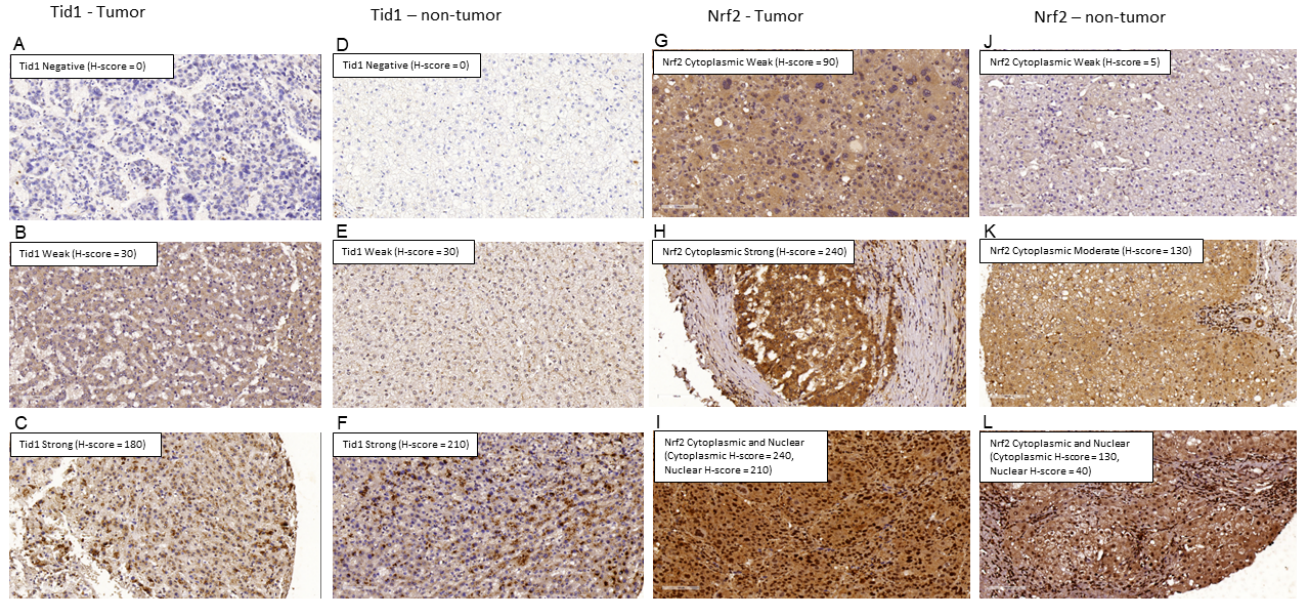
Figure 5. Examples of Tid1 expression in the tumor and non-tumor part. ( A ) Negative Tid1 expression in the tumor part. ( B ) Weak Tid1 expression in the tumor part. ( C ) Strong Tid 1 expression in the tumor part. ( D ) Negative Tid1 expression in the non-tumor part. ( E ) Weak Tid1 expression in the non-tumor part. ( F ) Strong Tid1 expression in the non-tumor part. ( G ) Weak Nrf2 expression in tumor part. ( H ) Strong Nrf2 expression in tumor part. ( I ) Cytoplasmic and nuclear Nrf2 expression in tumor part. ( J ) Weak Nrf2 expression in non-tumor part. ( K ) Moderate Nrf2 expression in non-tumor part. ( L ) Cytoplasmic and nuclear Nrf2 expression in non-tumor part.